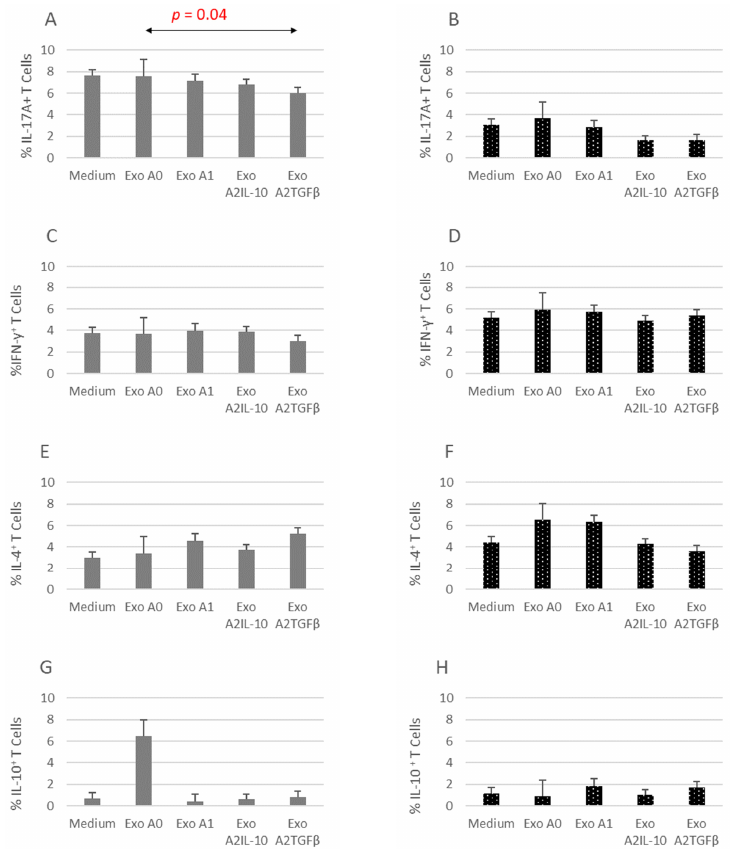
Figure 4. Results of flow cytometry analysis of cell composition. Mean percentages of CD3 + CD4 + cells producing IL-17 ( A , B ), IFN- γ ( C , D ), IL-4 ( E , F ) and IL-10 ( G , H ) cytokines are presented. Data for MS patients are in graphs with filled bars (7 persons), results for non-MS cells are in white dotted bars (4 persons). After 96 h of T-cell cultures in presence of astrocyte-derived exosomes or medium alone, culture media were collected, cells were suspended in new medium containing brefeldin A for 12 h; next, cells were harvested and stained for flow cytometry. Cells were analyzed as a % of CD3 + CD4 + cells positive for the individual cytokines. Data were shown as mean ± SE. Comparisons between variables were made with non-parametric Wilcoxon signed-rank test.